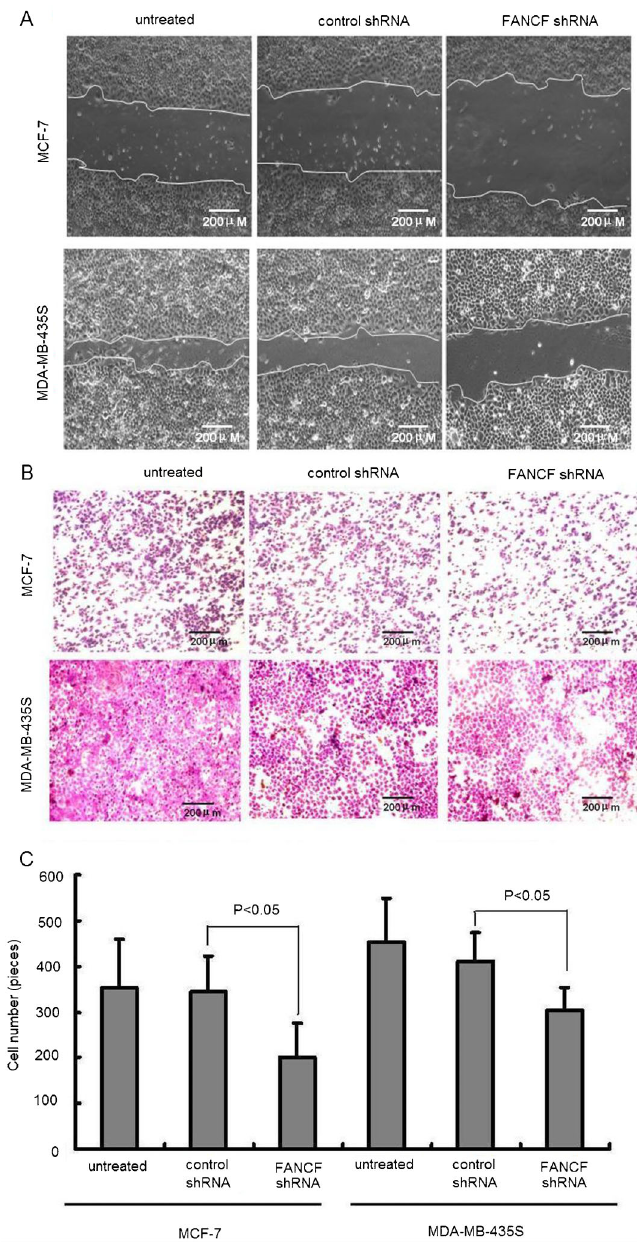
Figure 6. Silencing of FANCF suppressed migration and invasion in breast cancer cells. A , Representative image of wound healing assay of MCF-7 and MDA-MB-435S at 48 h after wound scratch. B , Representative images for invasiveness of MCF-7 and MDA-MB- 435S cells that migrated through transwell membranes with matrigel. C , Invasiveness of cells evaluated by counting cells that migrated through transwell membranes with matrigel. Data are reported as means±SD of three independent experiments in triplicate. ANOVA followed by the post hoc test was used for statistical